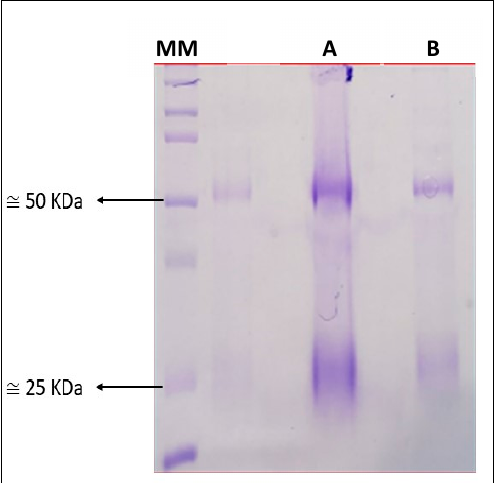
Figure 3. Titration of animal serum containing antibodies against rKPC-2. Legend: ( A ) titre of anti-rKPC-2 antibodies in rabbit serum; ( B ) titre of anti-rKPC-2 antibodies in mouse serum. The purification of antibodies using the affinity column recovered 44 mL with a concentration of 65.7 mg/mL and 300 µ L with a concentration of 1.29 mg/mL for the rabbit and mice, respectively (Figure 4).